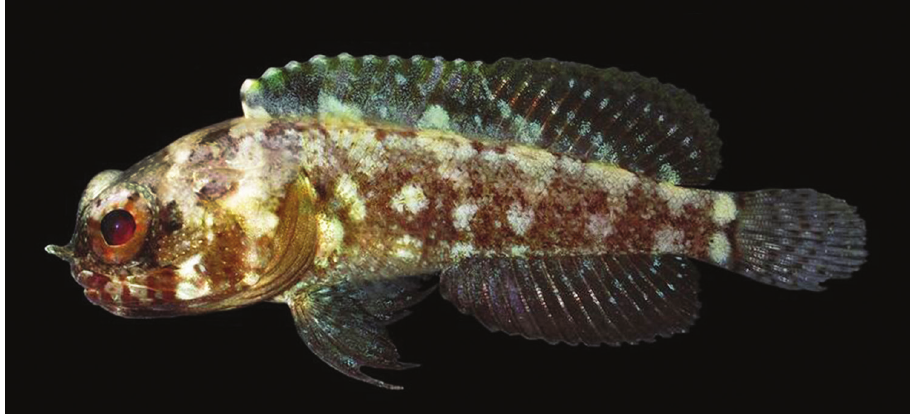
Figure 2. Opistognathus thionyi , NPM 5029, 38.4 mm SL, Enseada dos Portugueses, Trindade Island, Brazil. Photograph by Thiony Simon.